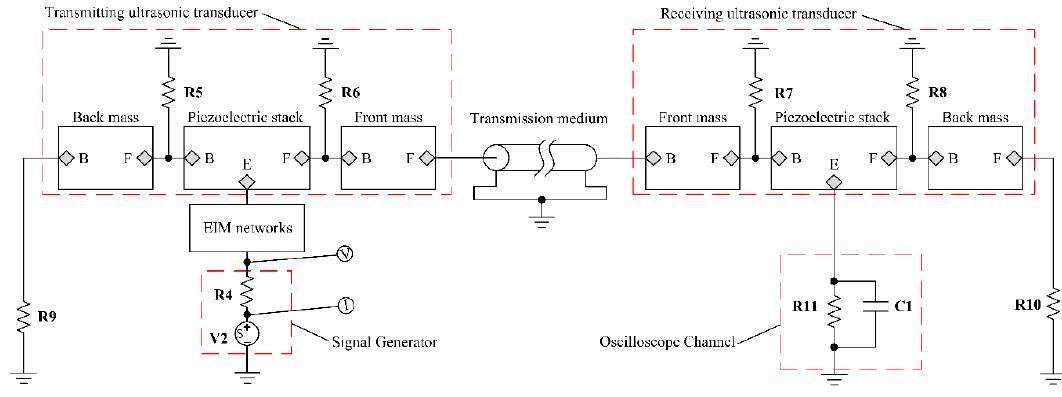
Figure 4. The pitch-catch setup with EIM networks.